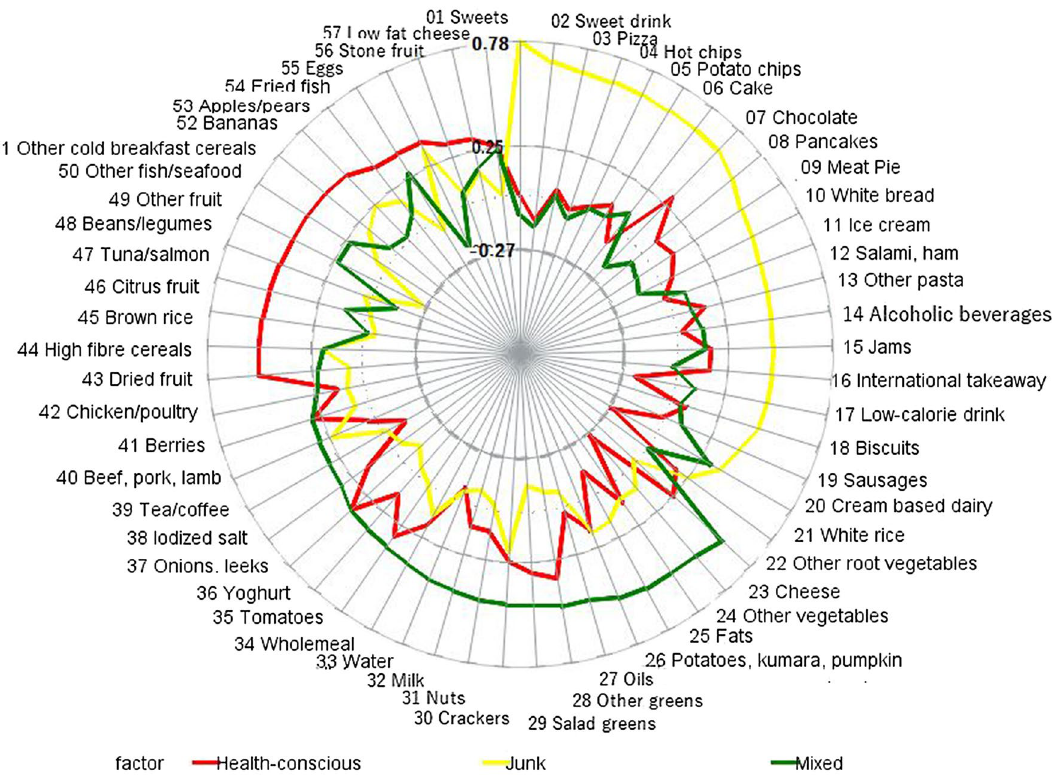
Figure 2. Food loadings for the three maternal dietary patterns